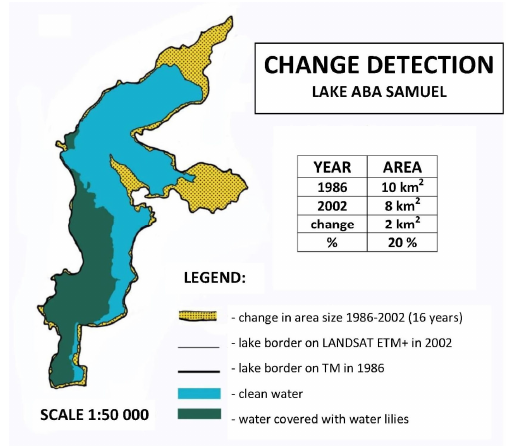
Figure 5. A part of land cover map in scale 1:50 000 with superimposed contours line